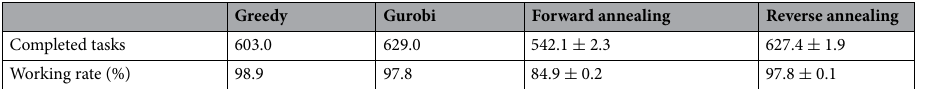
Table 1. Comparison of algorithms and solvers. The mean number of completed tasks for 500 iterations and the working rate of AGVs obtained by the greedy algorithm, Gurobi, forward annealing, and reverse annealing. Data are drawn from 10 identical experiments. The standard deviation is shown on the right hand side of the plus-minus